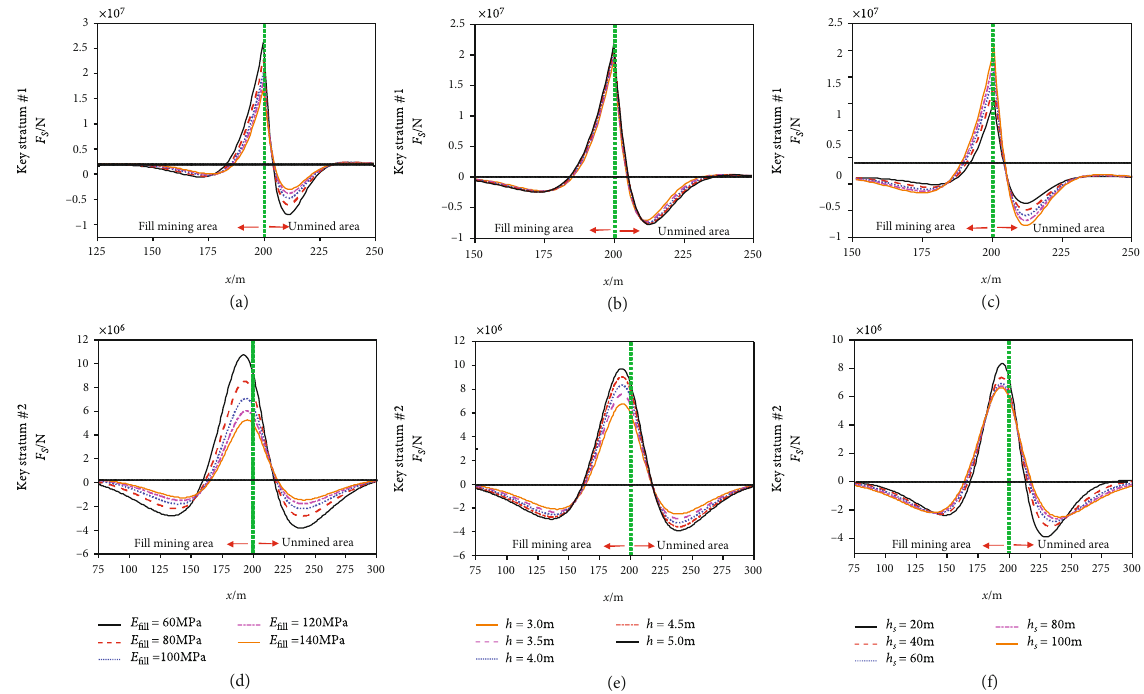
Figure 8: The shear force curves of key strata with the distance to the middle of the stope under various (a, d) elastic modulus of back fi ll, (b, e) mining height, and (c, f) thickness of soft